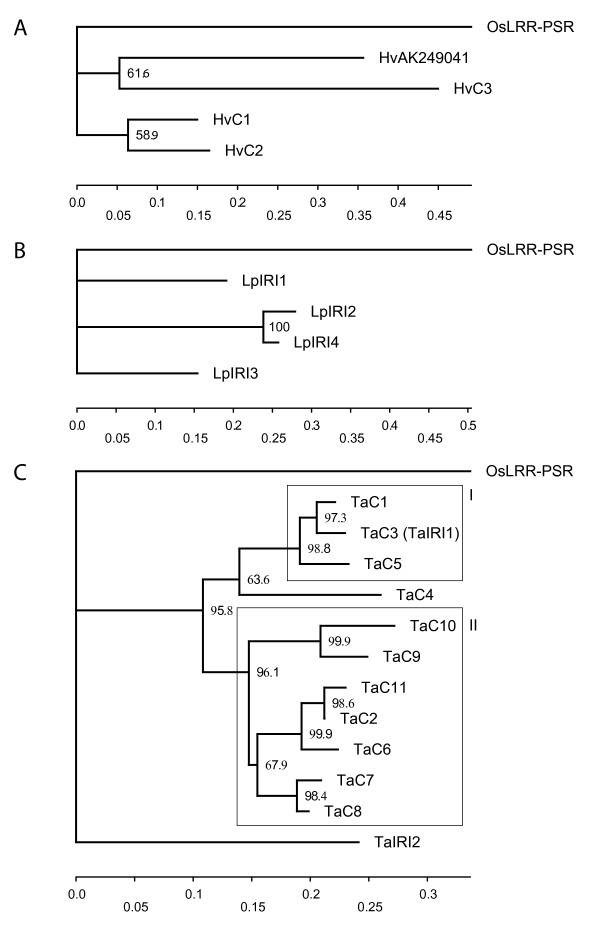
Maximum Likelihood paralog phylogenies of all full length IRI-like amino acid sequences. Bootstrap values from 1000 replicates are in percent at internal nodes. Bootstrap values < 50 are not shown. A) Phylogeny of barley IRI-like full length sequences. B) Phylogeny of perennial ryegrass IRI-like full length sequences. C) Phylogeny of wheat IRI-like full length sequences. Two monophyletic clades of very low within-clade synonymous divergence (I, II) are boxed.